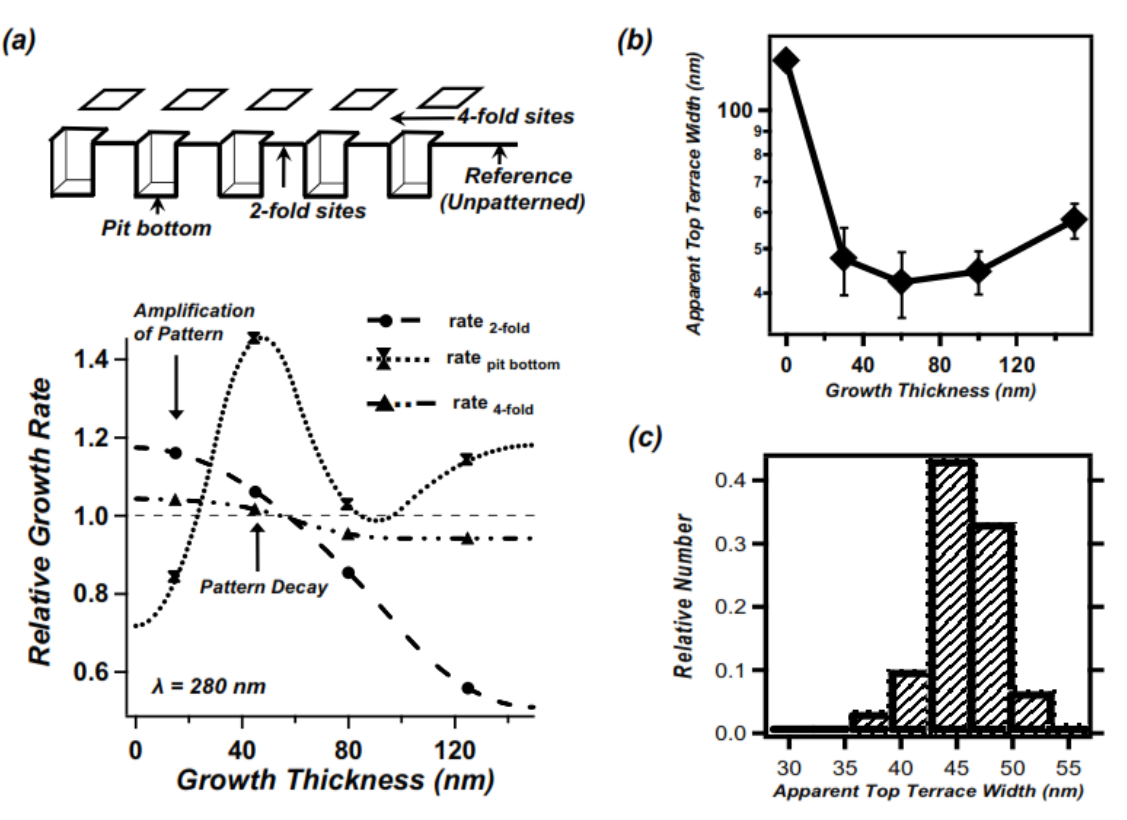
Figure 4. Growth rates and characteristics of pit array with λ = 280 nm ( a ) (top) Schematic showing positions referred to in growth rate analysis; (bottom) Growth rate, relative to level of unpatterned region of surface of mounds at 2-fold bridge sites (dashed line), mounds at 4-fold bridge sites (double dot-dashed line), nanopit bottoms (dotted line); markers show measured average rates, continuous curves are smooth interpolations, intended as a guide to the eye; ( b ) Measured widths of topmost terrace width for mounds at 2-fold bridge sites, measured along (cid:4670)110(cid:4671) ; ( c ) Histogram of measured topmost terrace widths for a range of pattern periods measured at the growth thicknesses corresponding to the